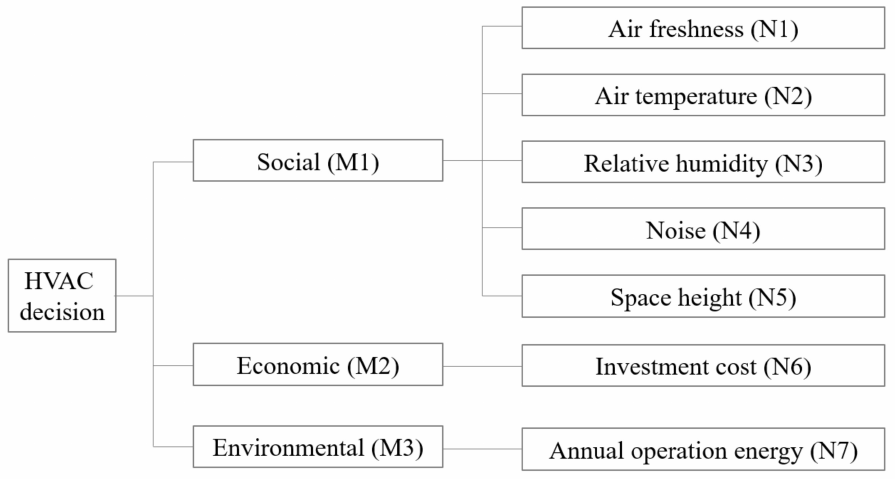
Figure 9. Assessment structure of